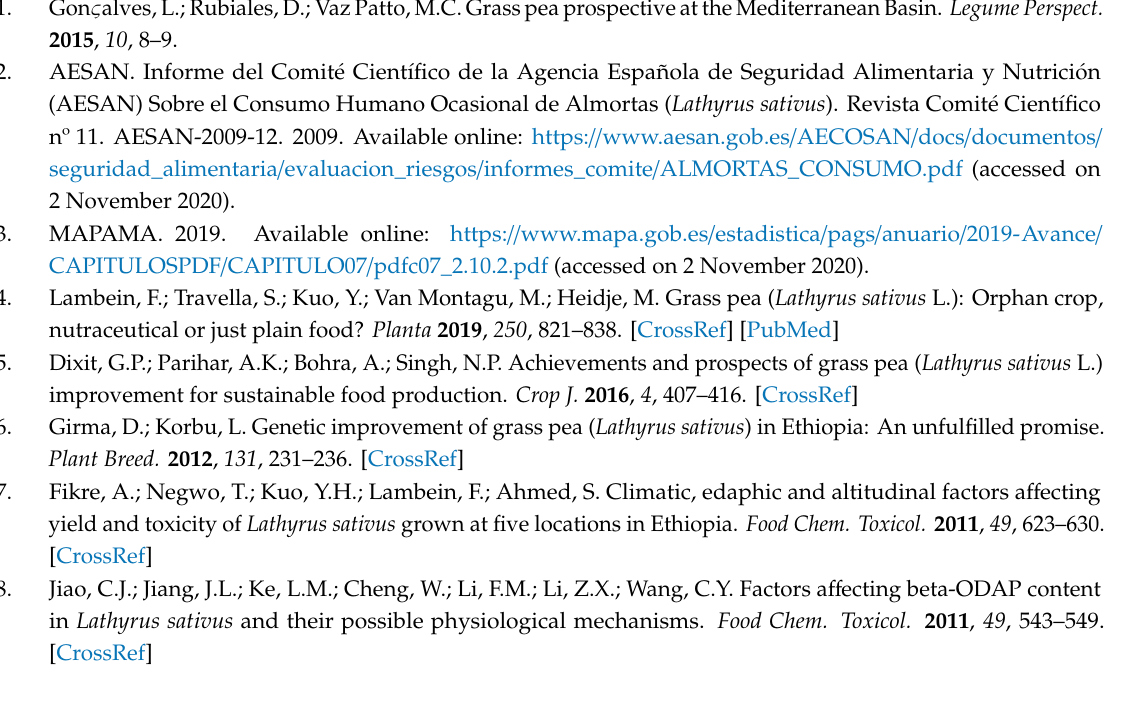
s1, Table S1: Climate variables including: maximum temperature (Tmax), minimum temperature (Tmin), maximum humidity (Hmax), minimum humidity (Hmin), radiation (Rad), rain and evapotranspiration (ETo) during di ff erent growing stages pre-flowering (Pre), flowering (Flow) and post-flowering (Post), characterizing the 17 environments (combinations of location and season) of the